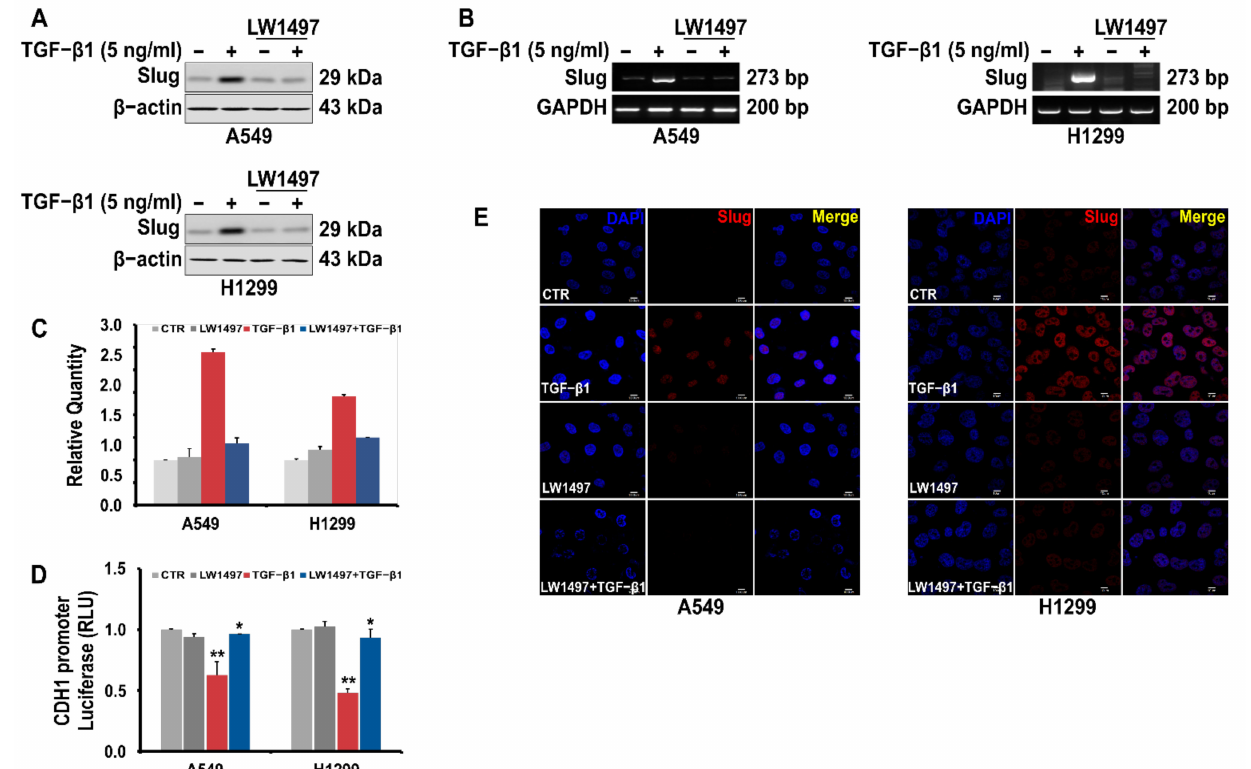
Figure 4. LW1497 inhibits TGF- β 1-induced Slug expression in lung cancer cells. ( A ) Effect of LW1497 on TGF- β 1-induced Slug expression in A549 and H1299 lung cancer cells. The expression level of Slug was measured by a Western blot, RT-PCR ( B ), and qRT-PCR ( C ). GAPDH was amplified for normalization. ( D ) Effect of LW1497 on CDH1 promoter activity. A549 and H1299 cells were pretreated with 10 µ M of LW1497 for 2 h and then stimulated with 5 ng/mL of TGF- β 1. After 1 day of treatment with LW1497 and TGF- β 1, cells were transfected with luciferase constructs of wild-type (CDH1 pro-WT) CDH1 promoters for 24h and the luciferase activity was measured. RLU, relative light units. * p < 0.05, ** p <0.01. To compare the ratio between the control and the experimental groups, the fold change was calculated based on the control. ( E ) Confocal microscopic analysis of the effect of LW1497 on TGF- β 1-induced Slug expression in lung cancer cells. DAPI staining was used to identify the nucleus. Bar, 10 µ